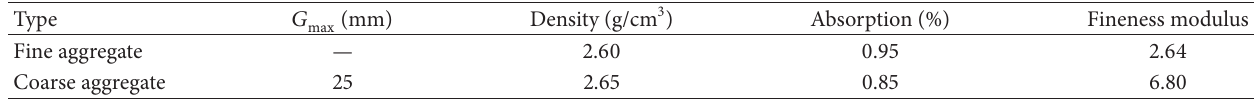
Table 3: Physical properties of aggregates.